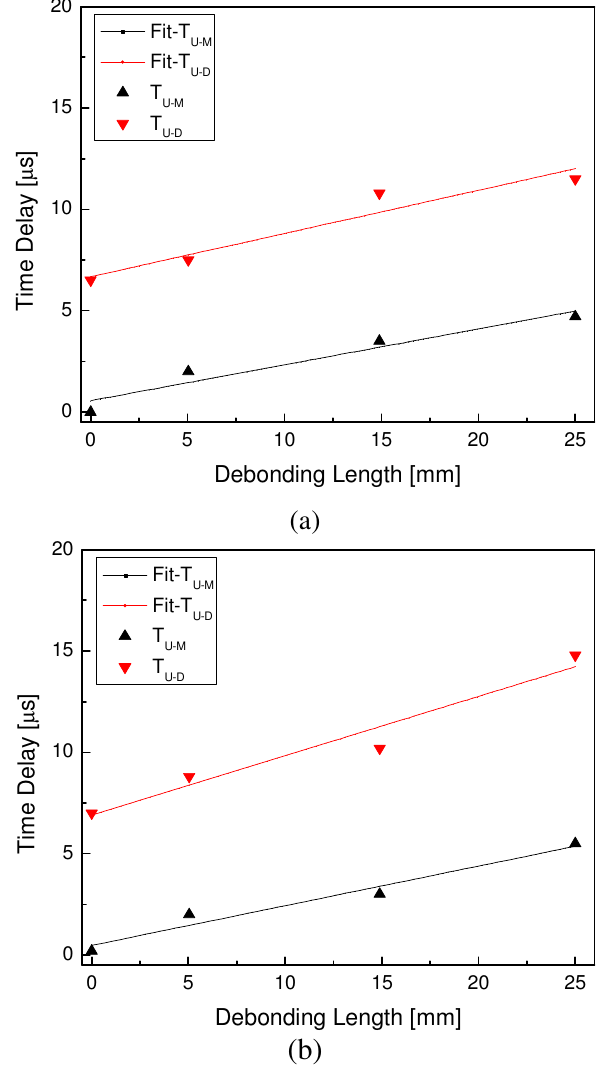
Figure 9. The relations and their linear fittings between the debonding length and the time delay at incident frequencies (a) 330 kHz and (b) 280 kHz.